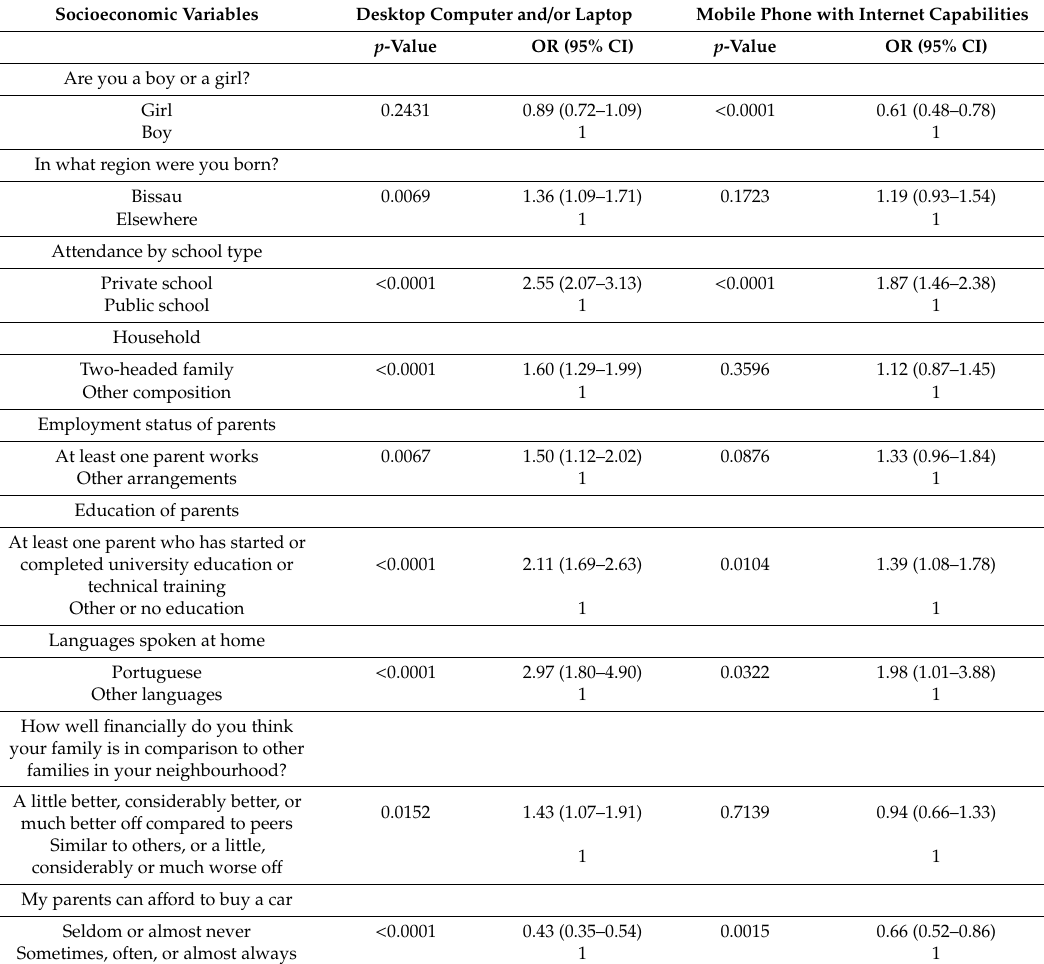
Table 3. Bivariate analysis for explanatory socioeconomic variables for experience in the use of computers and / or laptops, and mobile phones with internet capabilities. Adolescents attending schools in Bissau, June 2017